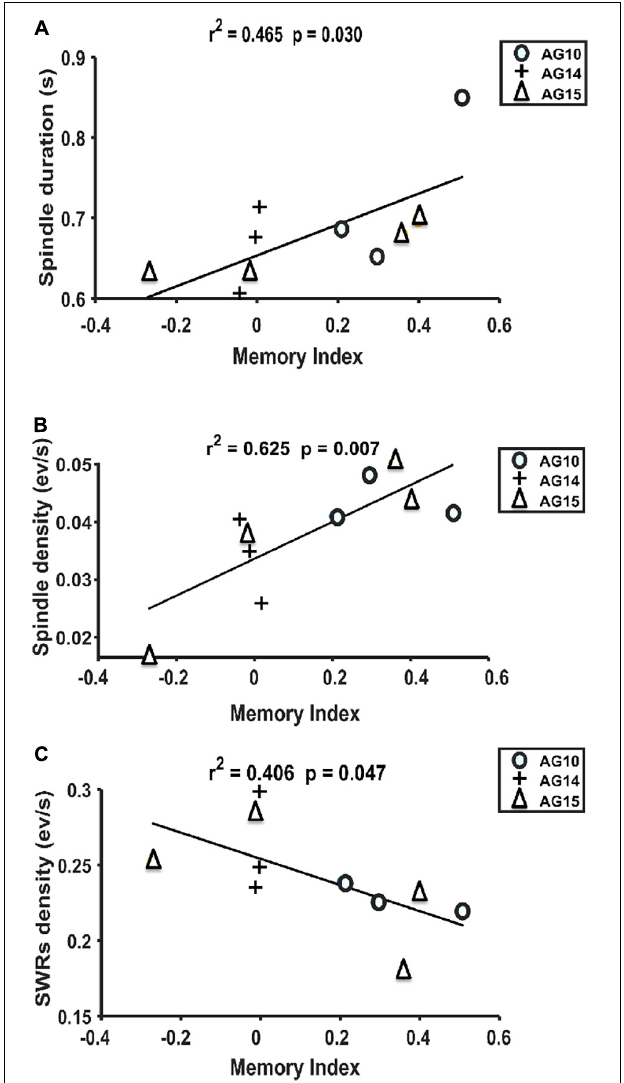
FIGURE 10 | Linear regression between Spindles and SWR features concerning memory performance. (A) Spindle duration and memory performance positively correlate ( r 2 = 0.465 and p = 0.030). (B) Spindle density (events/min) respect to memory index gets also positively correlated ( r 2 = 0.625 and p = 0.007). (C) SWR density (events/min) and memory index show a negative correlation ( r 2 = 0.406 and p = 0.047). Each symbol represents different animals; only those that reached a significant memory index by P32 were included ( n = 3). Two data points are missing because one animal did not fall asleep 1 day, and at P32, one animal lost the electrode recording